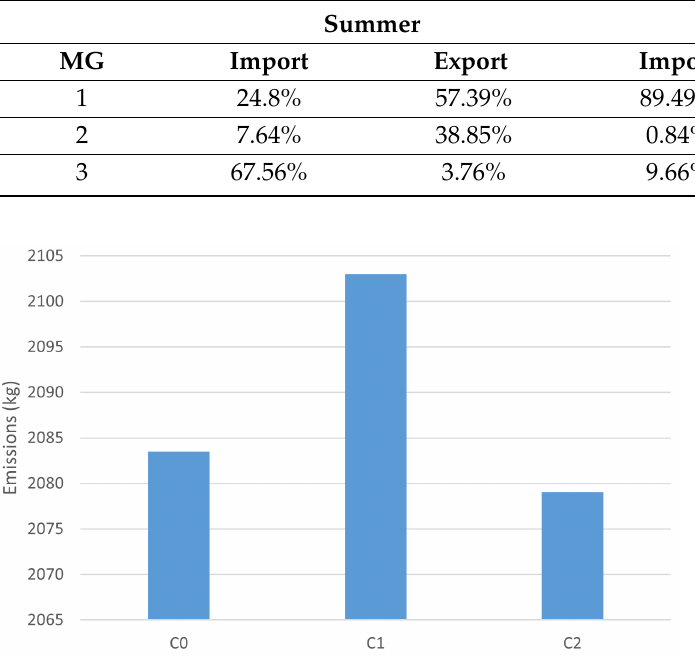
Figure 3. The total emissions of CO 2 in C0, C1 and